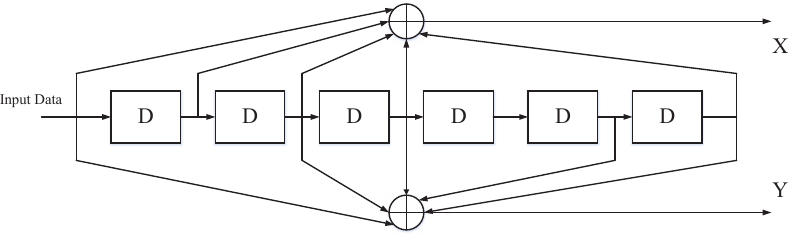
Figure 13. Convolutional coding module block diagram.